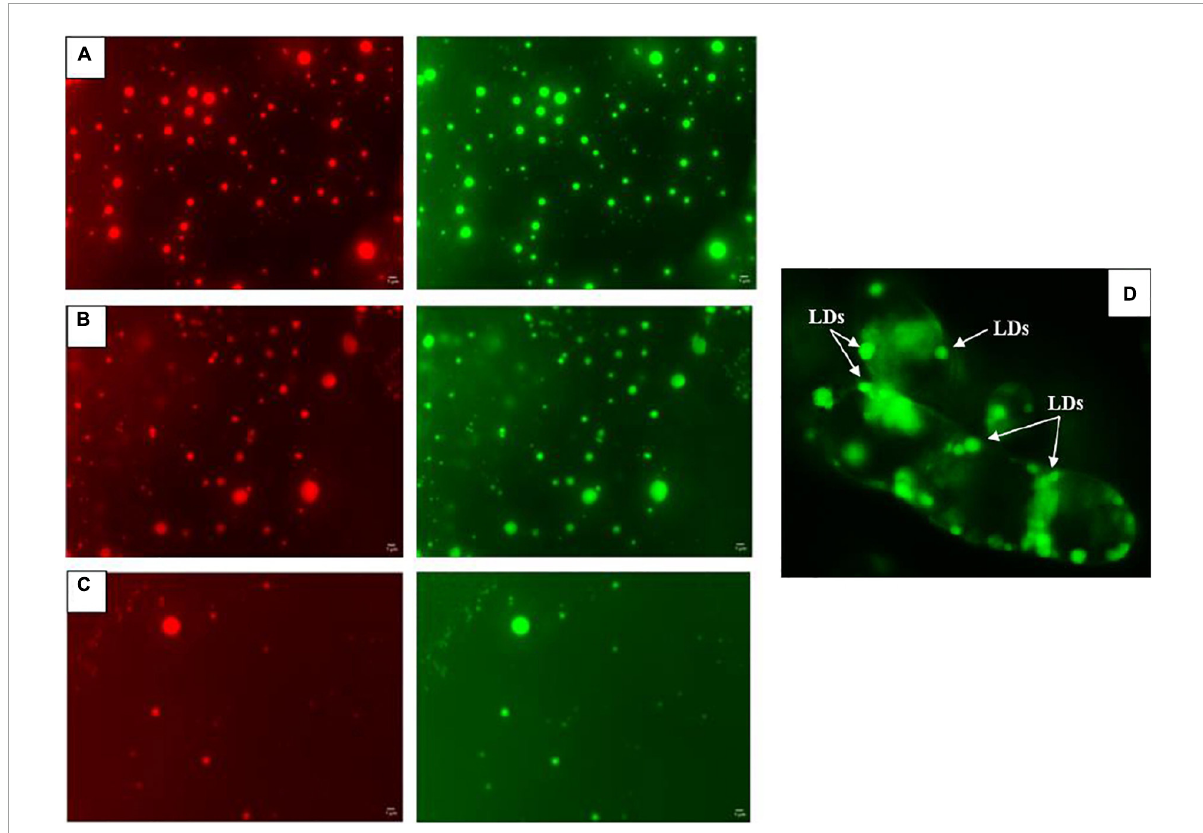
FIGURE2 Example of detected isolated LDs under green and red fluorescence filters at 20 days of culture in COR (A) , CC (B) and Control (C) conditions with a fluorescence microscope at 10X ocular and 20X objective. Image (D) shows a clump of T. baccata cells with stained LDs bordering the cell wall using a green fluorescence filter at the same magnifications and 20 days of culture in COR-treated